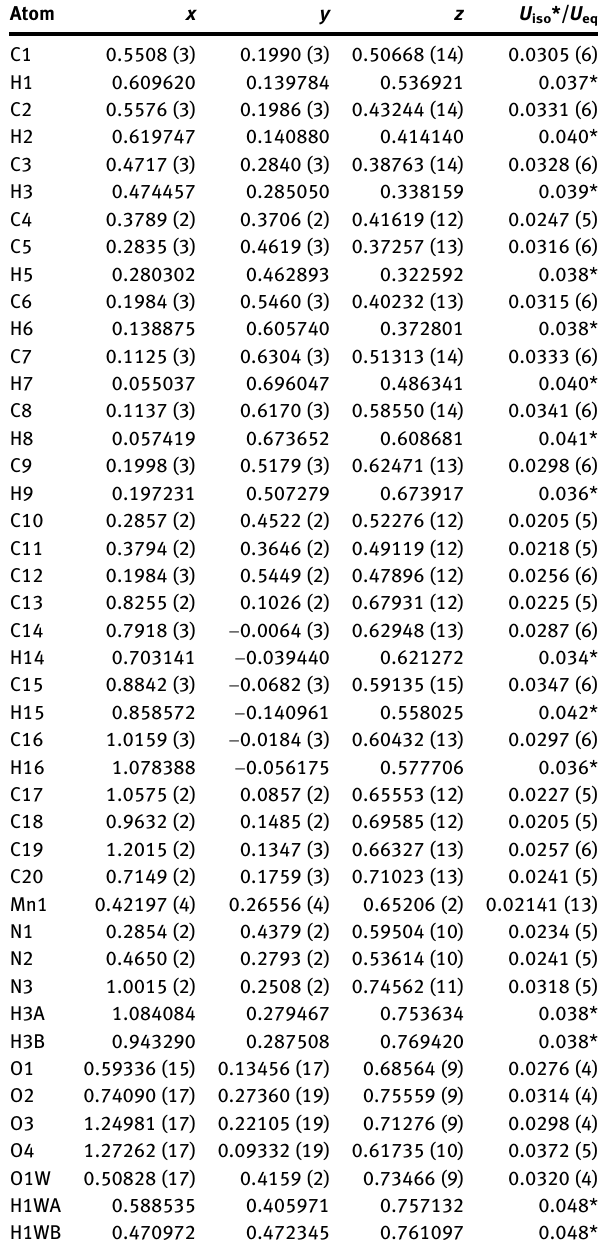
Table  : Fractional atomic coordinates and isotropic or equivalent isotropic displacement parameters (Å 